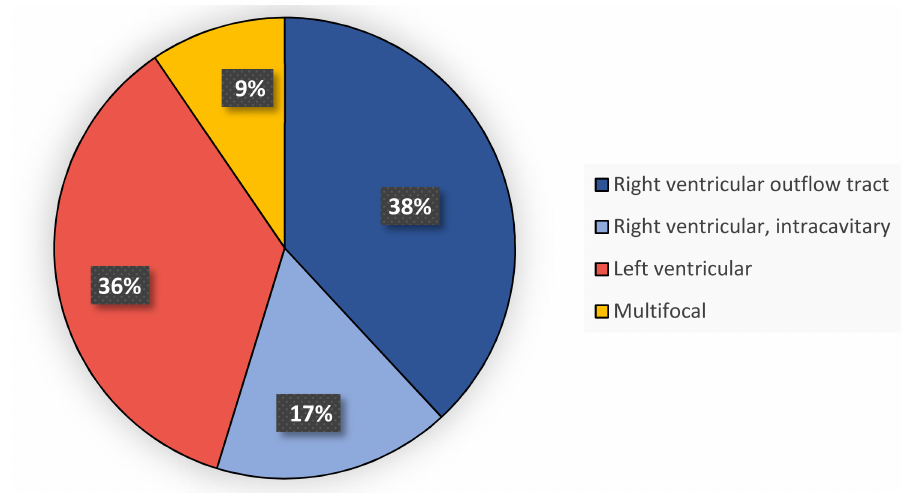
Figure 1. PVC morphology in 42 patients with PVC recorded on 12-lead ECG.